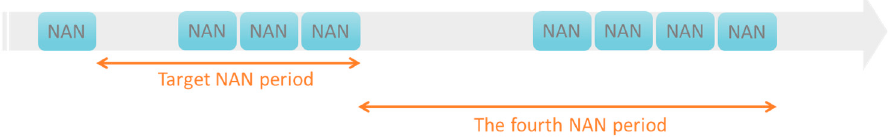
Figure 6. Time graph of the relationship between the target NAN period occurring before the NAN period of the fourth class.